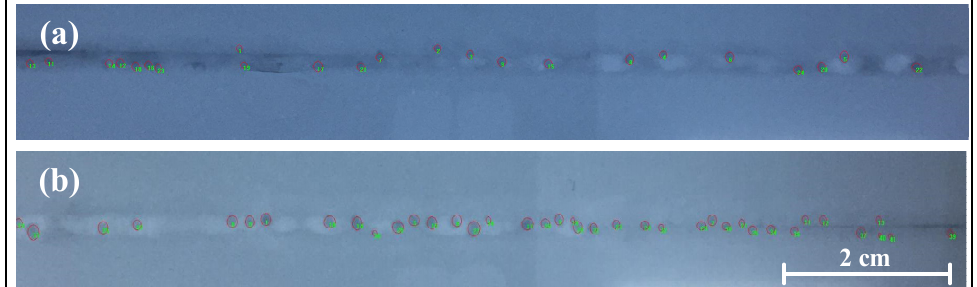
Figure 13. Internal porosity of weld with different welding speeds. ( a ) P = 4.0 kW, I = 90 A, v =1.5 m/min; ( b ) P = 4.0 kW, I = 90 A, v = 1.2 m/min.